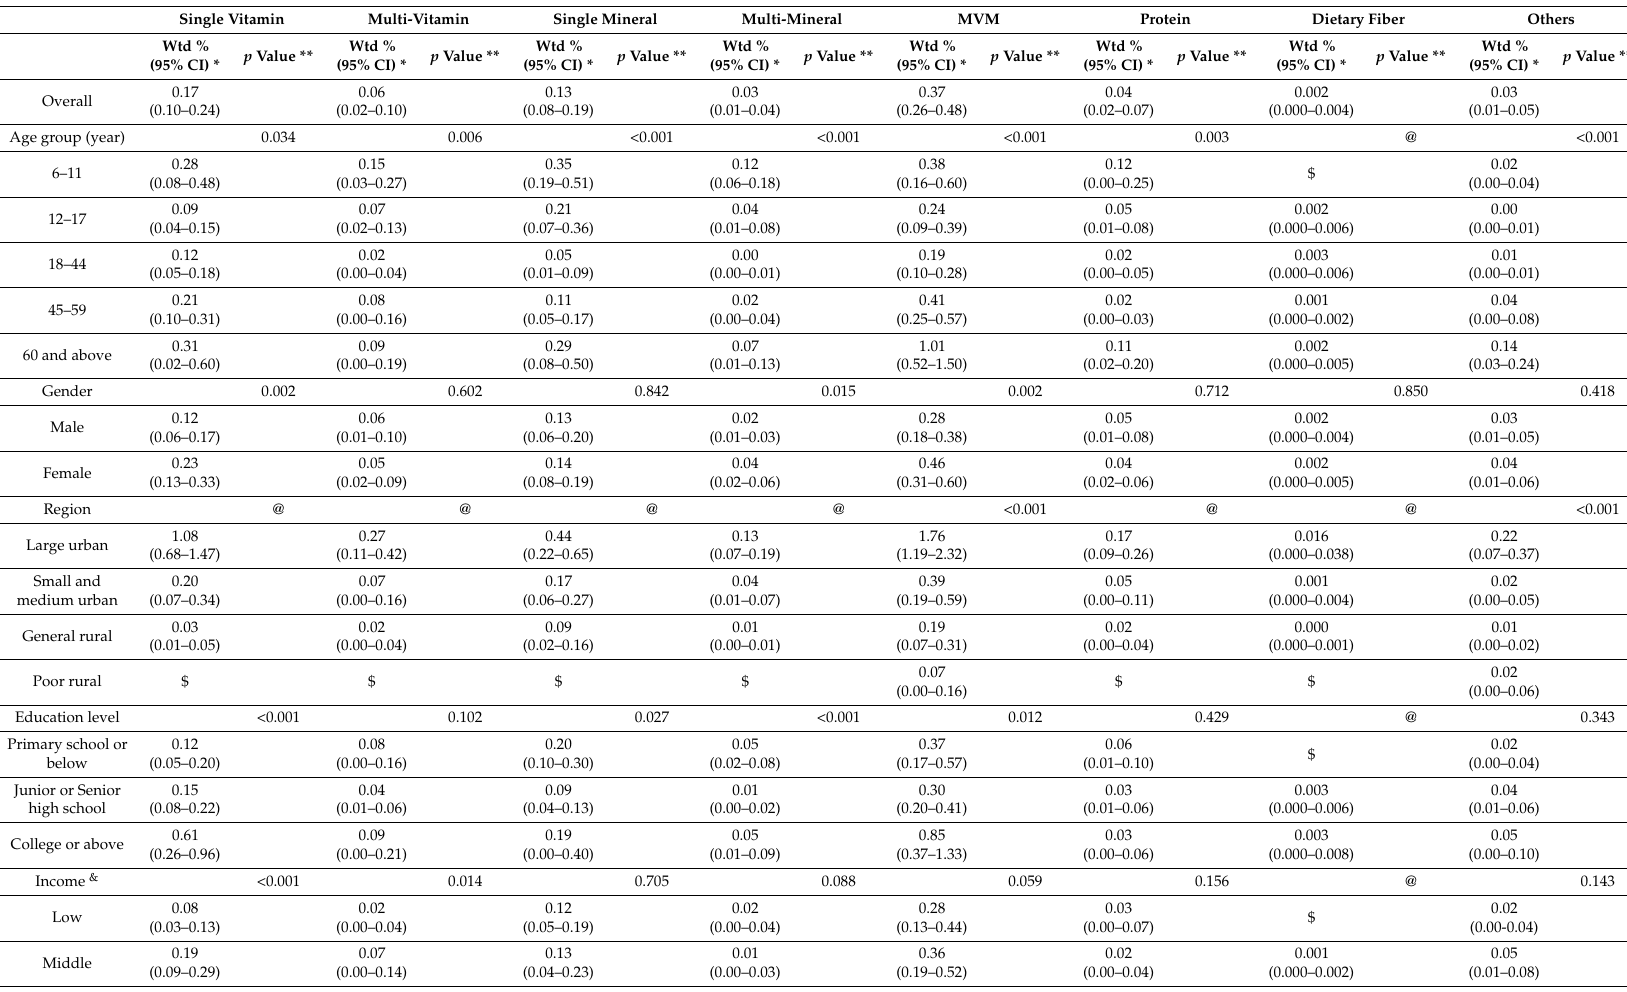
Table 2. Type of nutrient supplements use among the Chinese population aged 6 years and above in 2010-2012